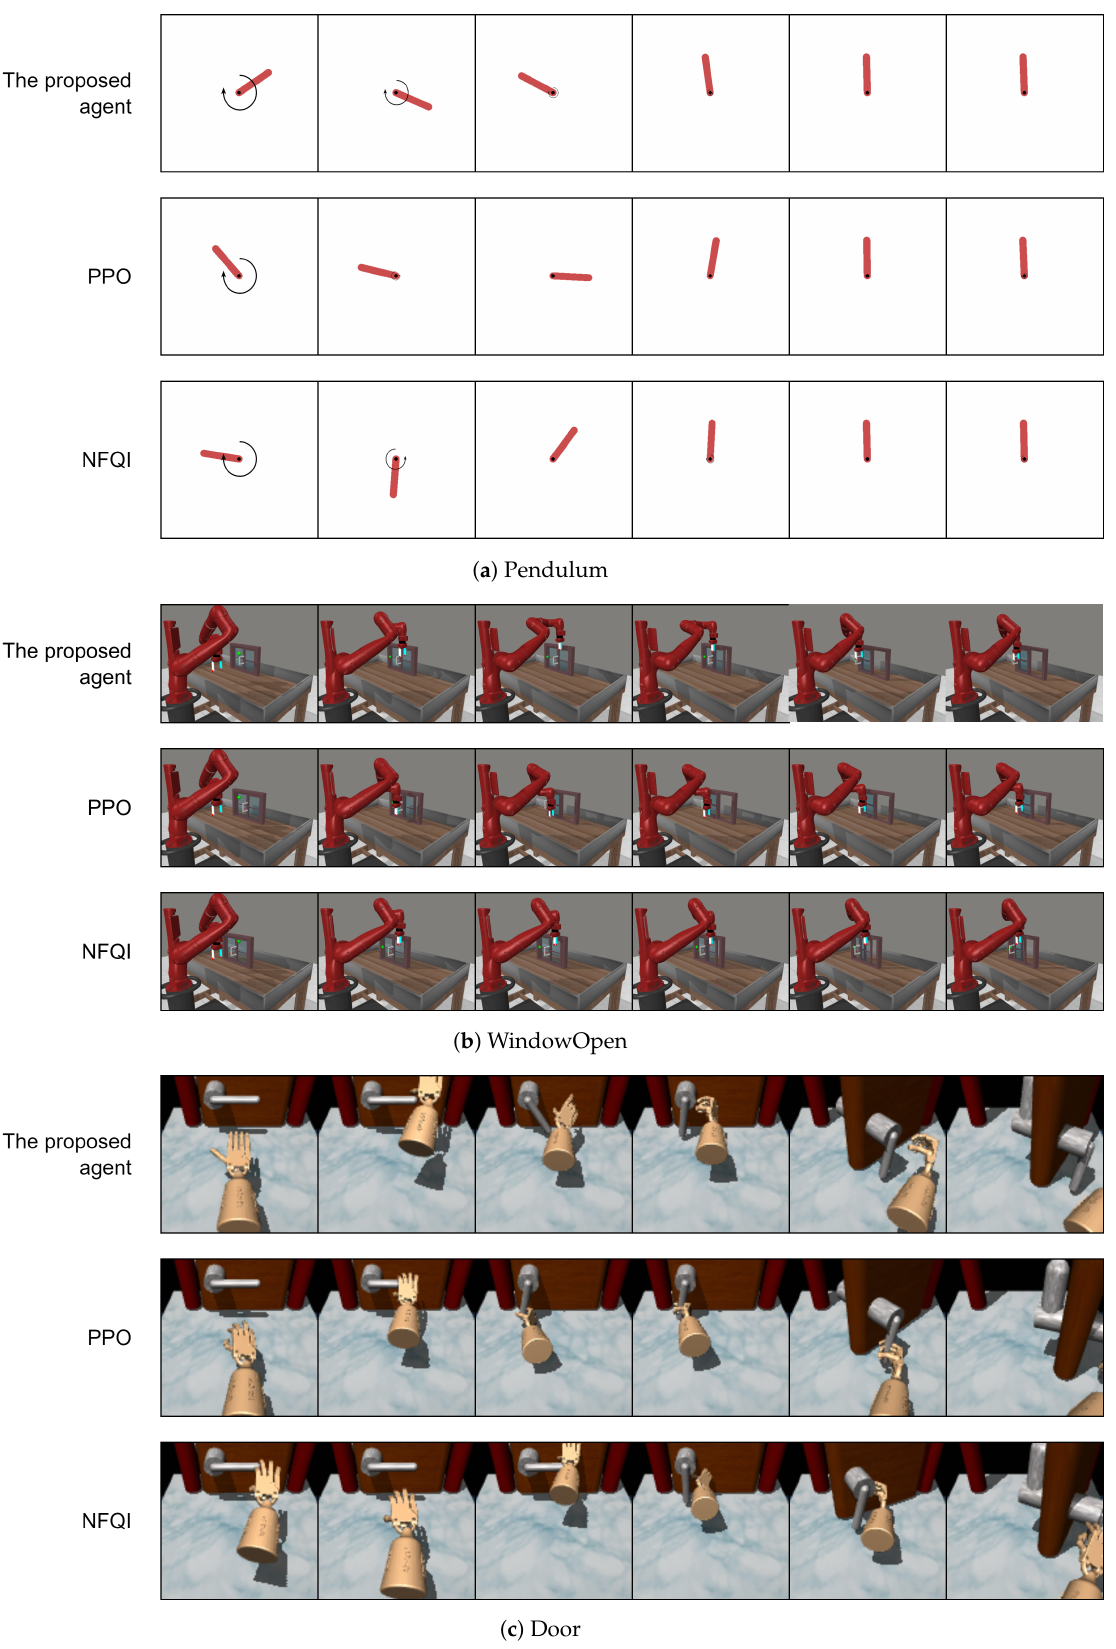
Figure 5. A visualization of the behavior of the proposed agent and baselines on source